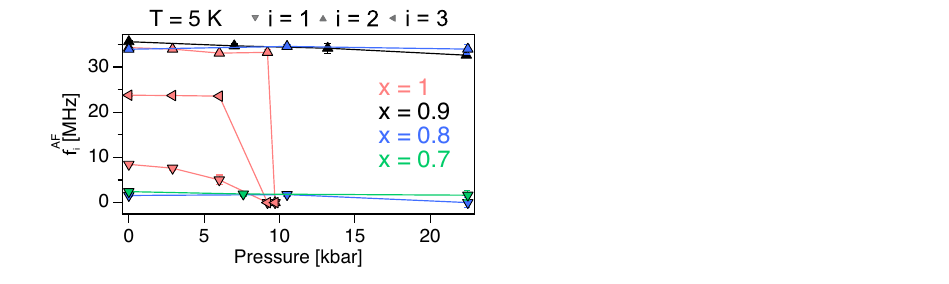
Figure 4. Pressure dependent precession frequencies, collected at T = 5 K, of Sr 1 − x Ca x Co 2 P 2 compounds obtained through Eq. (1): x = 1 (light pink), 0.9 (black), 0.8 (blue) and 0.7 (green). The solid lines are guide to the